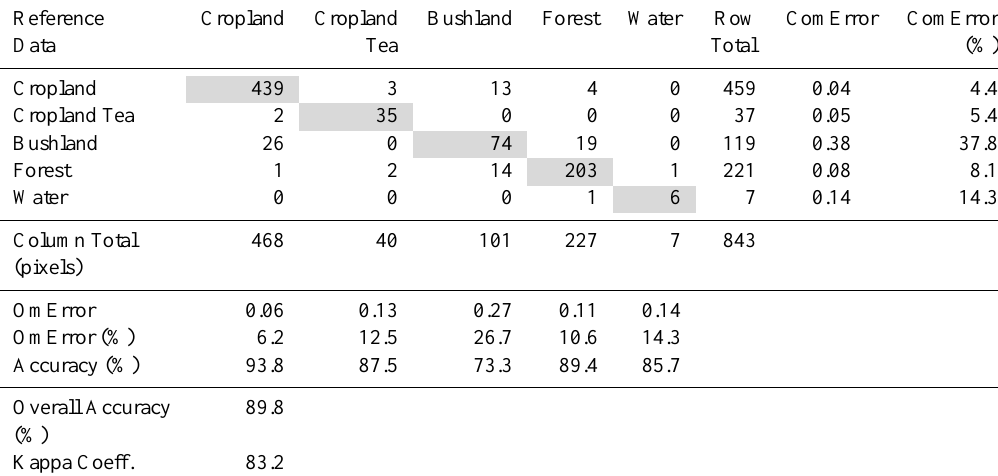
Table 3. Land cover classification accuracies as provided by binary recursive partitioning algorithm in conditional inference framework. comError=proportional error of commission, omError=proportional error of